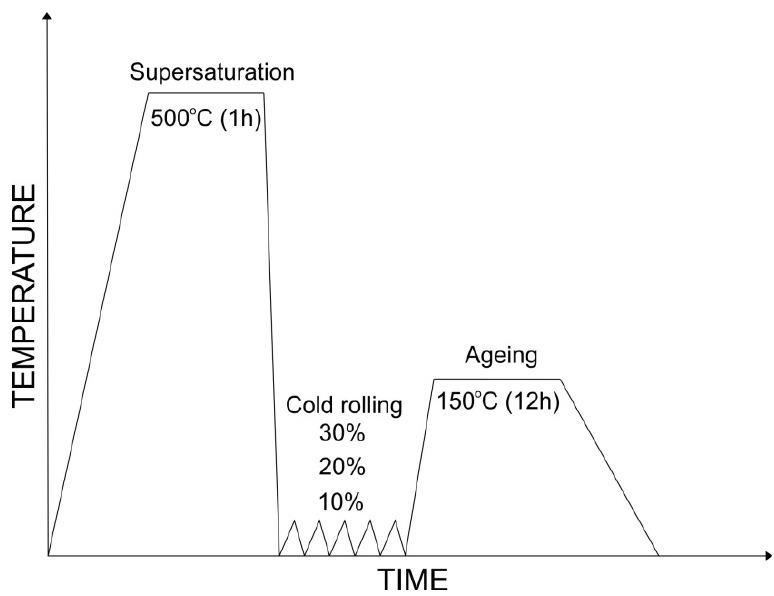
Figure 1. Scheme of low-temperature thermomechanical treatment of AlZn6Mg0.8Zr alloy.